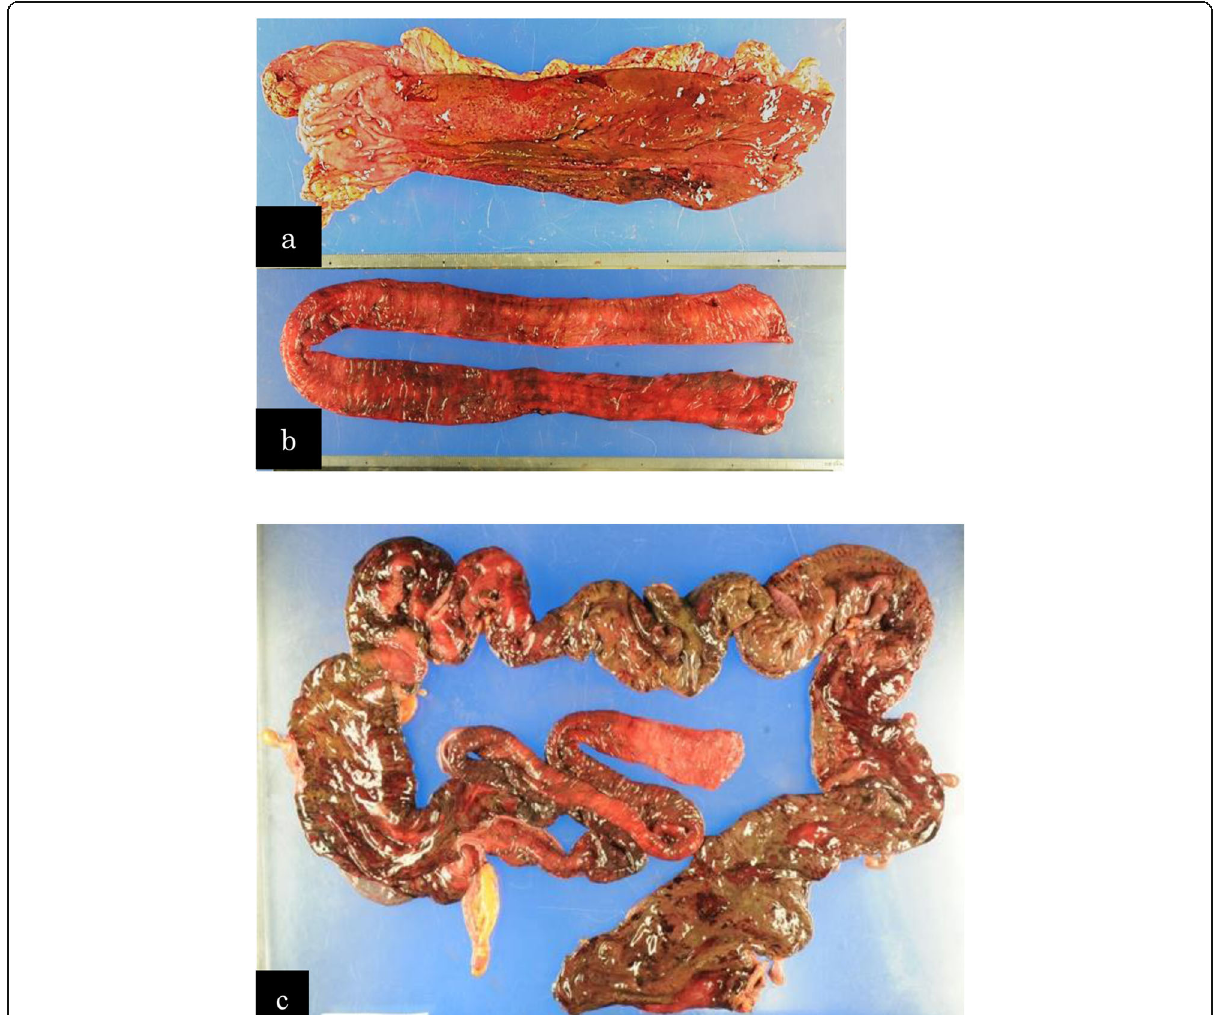
Fig. 5 Macroscopic findings of the resected specimen. a Gastric tube. Macroscopic color was worse, especially in the upper region. b Additional resected small intestine. c Ileum and large intestine. Almost all of the large intestines exhibited ischemic